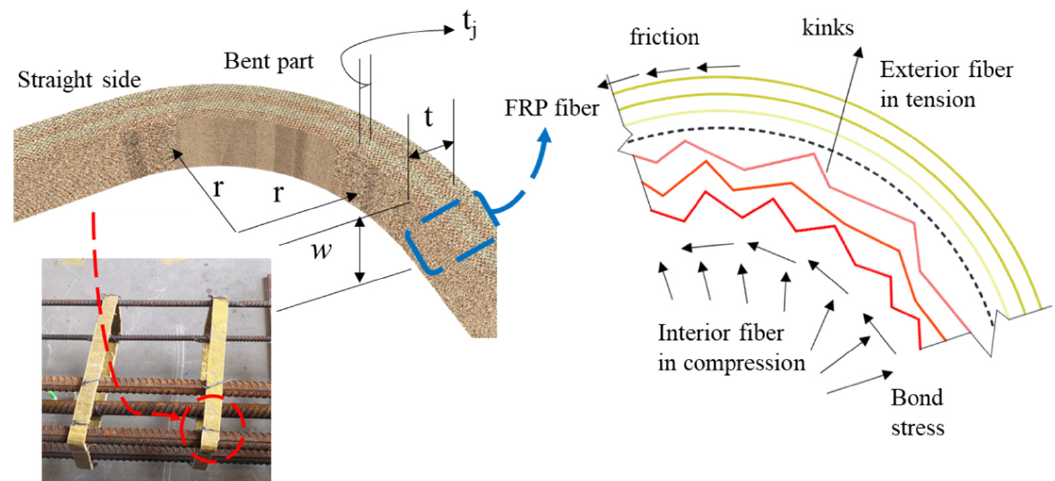
Figure 2. Stress concentration of bent FRP.